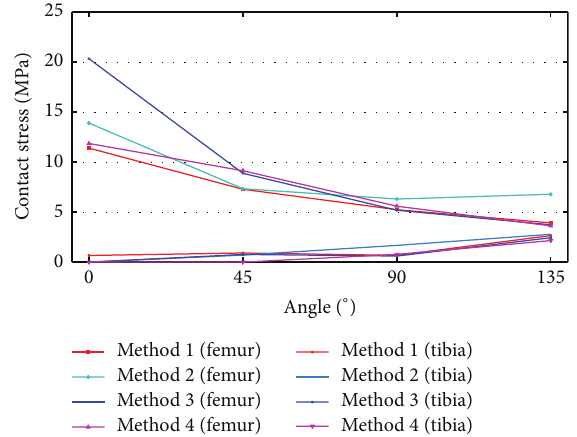
Figure 15: Contact stress changes in the models between bone and